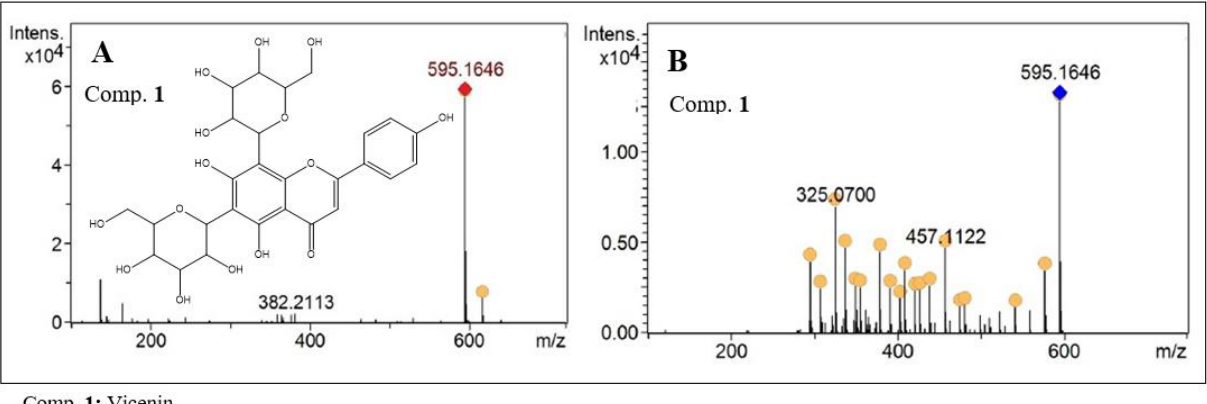
Figure 4. MS 1 ( A ) and MS 2 ( B ) spectra of C-glycosyl flavone present in the ethanolic extract of F. chica leaves. F. chica